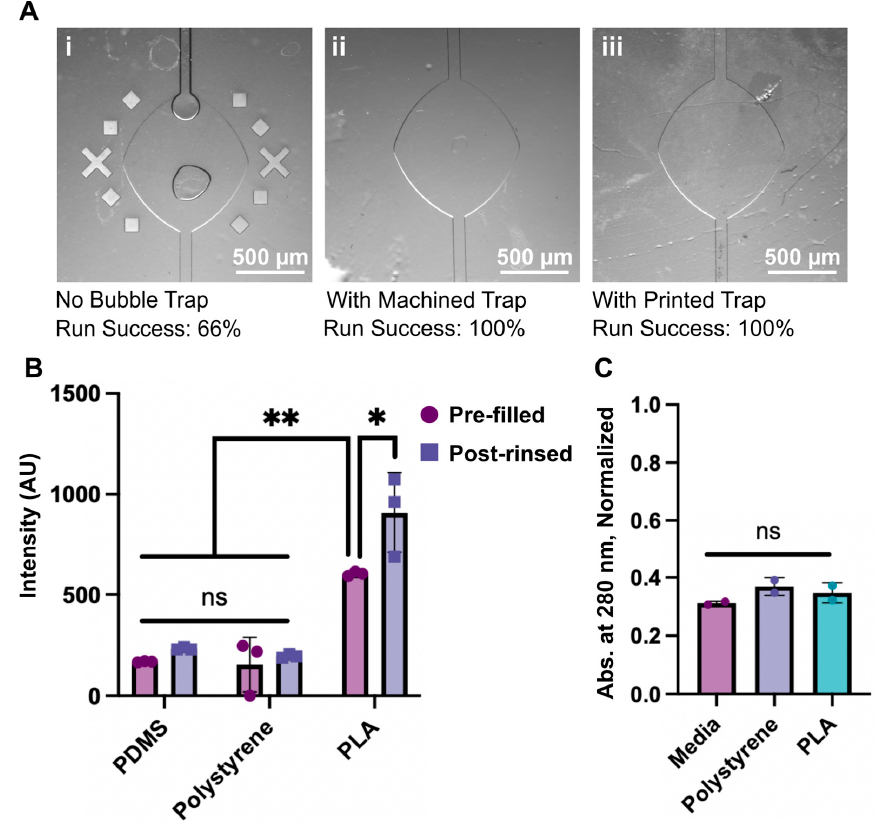
Figure 4. Degassers mitigated bubbles from upstream flow through microfluidic chips, with minimal absorption or leaching. ( A ) Photos of chips after media was perfused overnight (1 µm/min, 20 h, 37 °C) with or without in-line bubble traps (n = 3 chips), with the fraction of chips that contained no bubbles (“run success”) noted below. The X’s and squares in the left image are alignment markers that were included in some of the chips. ( B ) Plot of fluorescent signal from absorption of rhodamine into bubble trap materials before and after 24-h exposure. Two-way ANOVA, ** p < 0.0093, * p = 0.0377, ns > 0.9998, n = 3. ( C ) UV-Vis absorbance (A 280 ) of AIM-V media after overnight perfusion through the traps, compared to non-conditioned media. One-way ANOVA, ns > 0.2297. Points indicate individual samples, bars show the mean and standard deviation.